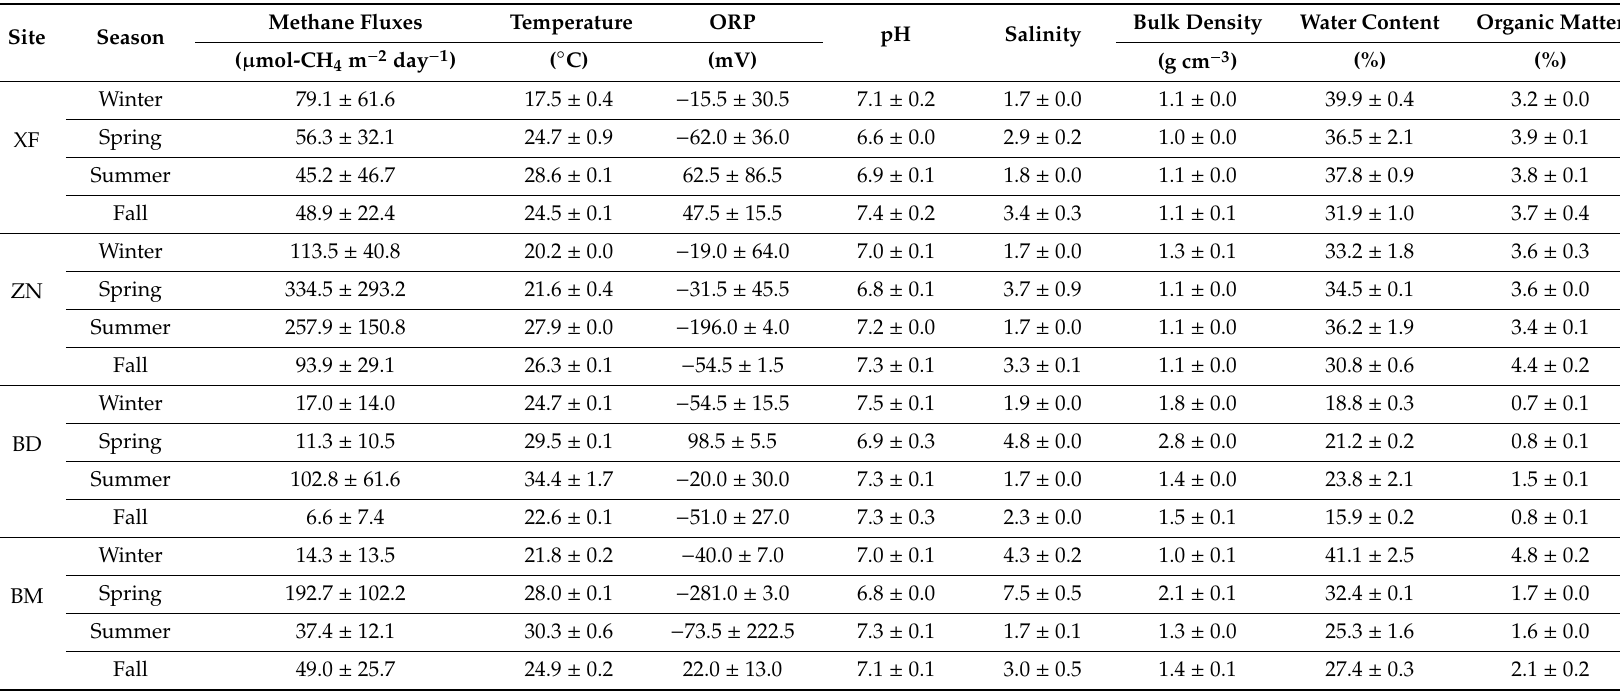
Table 3. Seasonal variations in methane fluxes and soil physiochemical parameters (Mean ± standard error) of the four adjoining mudflats. No significant seasonal di ff erence was detected for all variables at each mudflat site with the Kruskal–Wallis test and Tukey’s honestly significant di ff erence (HSD) test and the Bonferroni correction for the significance level. ORP: redox